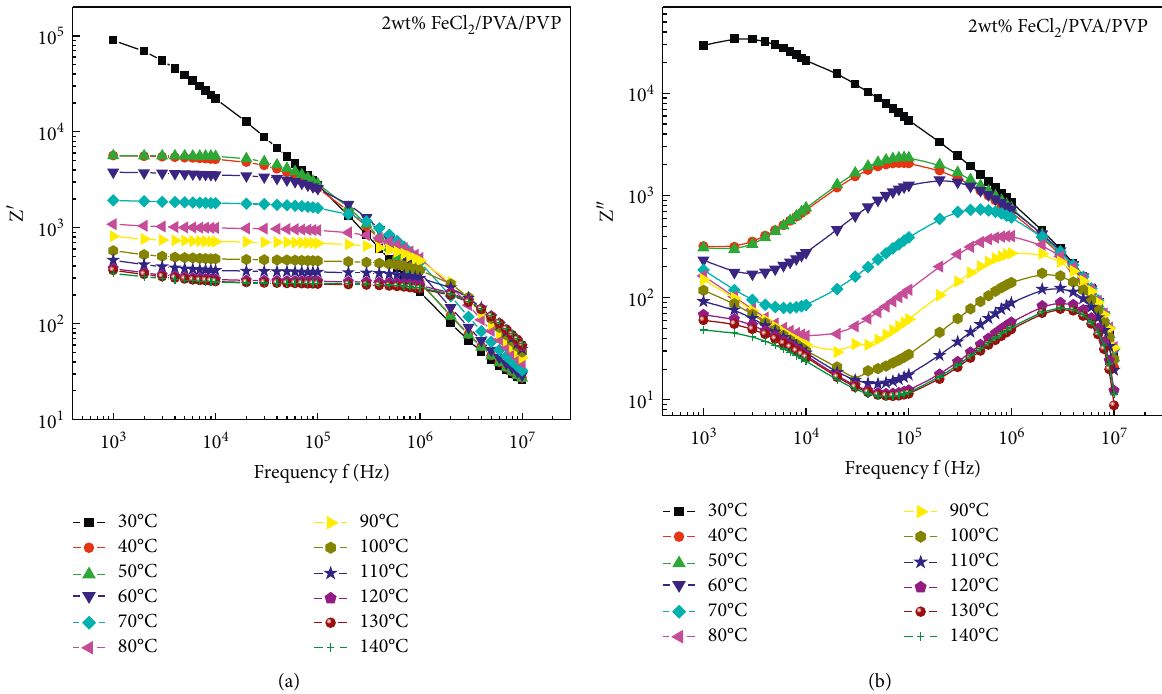
Figure 5: (a) Real part of impedance (Z ′ ) and (b) imaginary part of impedance (Z ′ ) for 2wt.% FeCl illustrate the variation of AC conductivity ( σ of frequency and at different temperatures for pure 50 wt.%